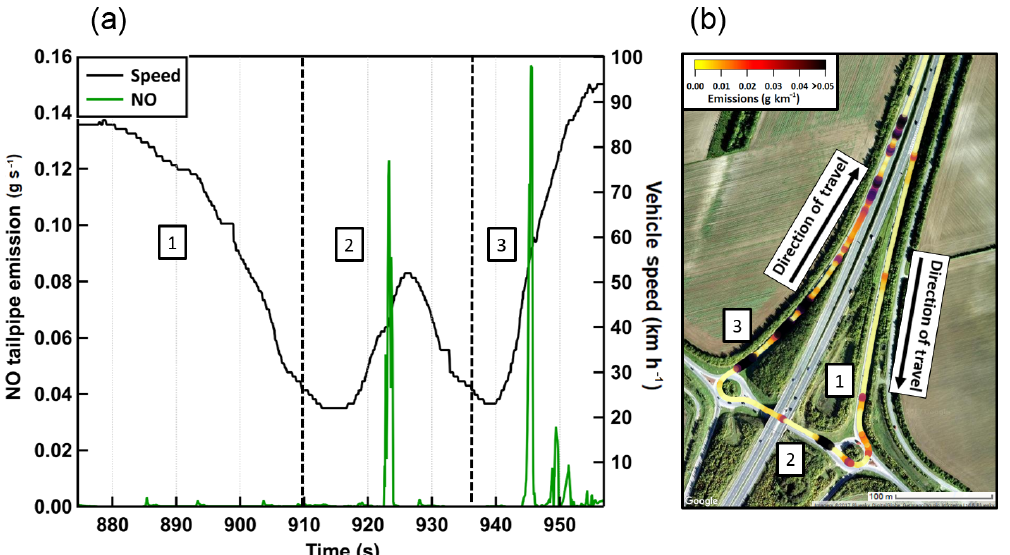
Figure 4. Emissions measurements associated with coming off, traversing, and rejoining a motorway shown in three sections; (1) exiting the motorway, (2) crossing under the motorway, and (3) rejoining the motorway. Panel (a) shows the fast NO emissions (gs − 1 ) with vehicle speed on the right axis, and panel (b) shows the route of the vehicle, coloured by NO emissions in gkm − 1 . Note the different units on the scales for each plot, and that values over 0.05gkm − 1 are all coloured black in order give sufficient dynamic range on the colour